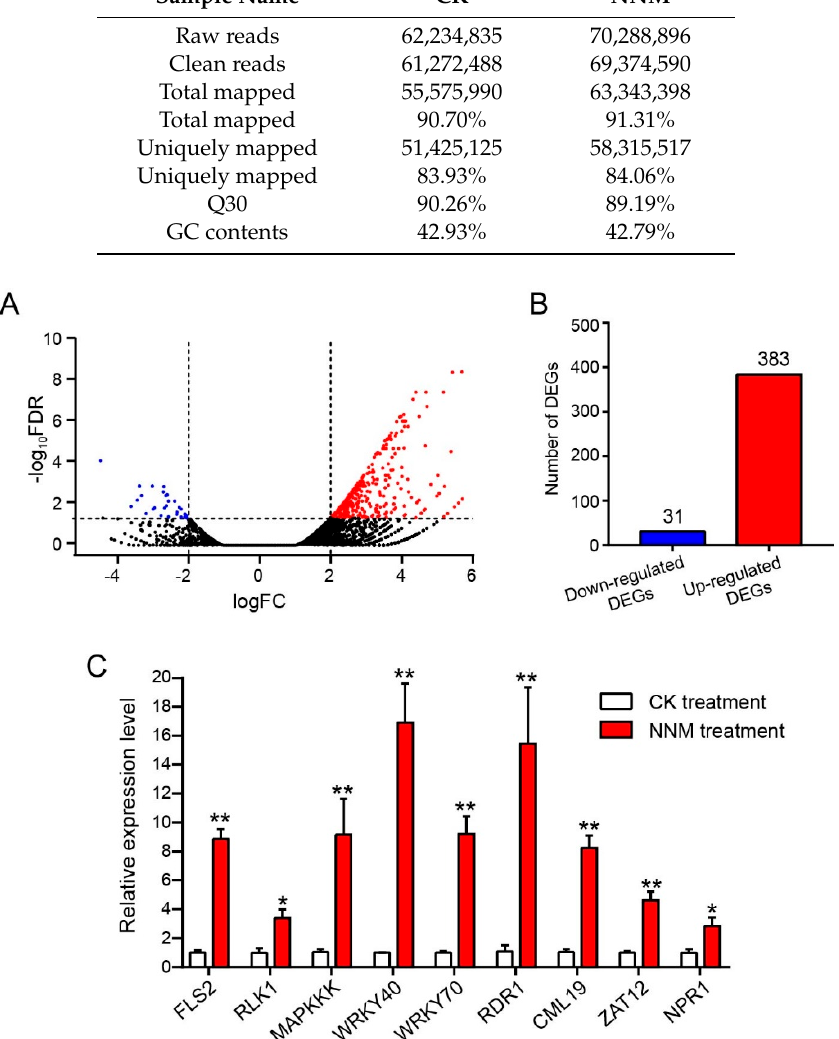
Table 1. Read numbers aligned onto the Nicotiana tabacum reference genome by Illumina sequencing.